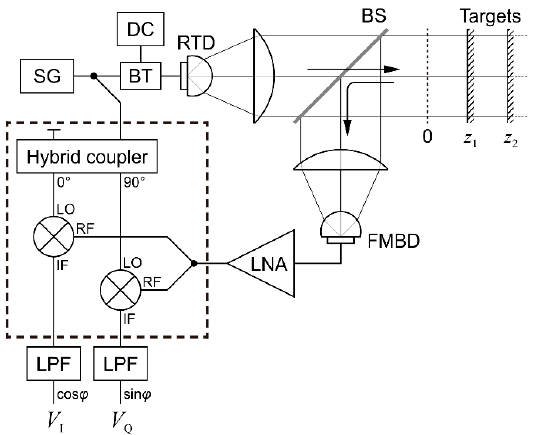
Figure 1. Schematic of the measurement setup. SG: signal generator; BT: bias tee; DC: power supply; BS: beam splitter; FMBD: Fermi-level-managed barrier diode detector; LNA: low-noise amplifier; LO: local oscillator input; RF: radio frequency input; IF intermediate frequency output; LPF: low-pass filter. Two power dividers are represented symbolically. The dashed rectangle is a commercial connectorized IQ